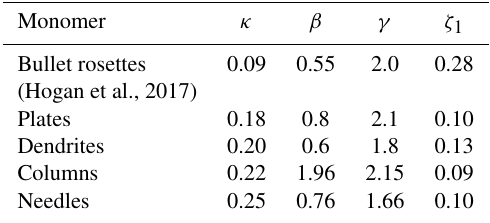
Table 1. SSRGA parameters fit to simulated aggregates of a range of